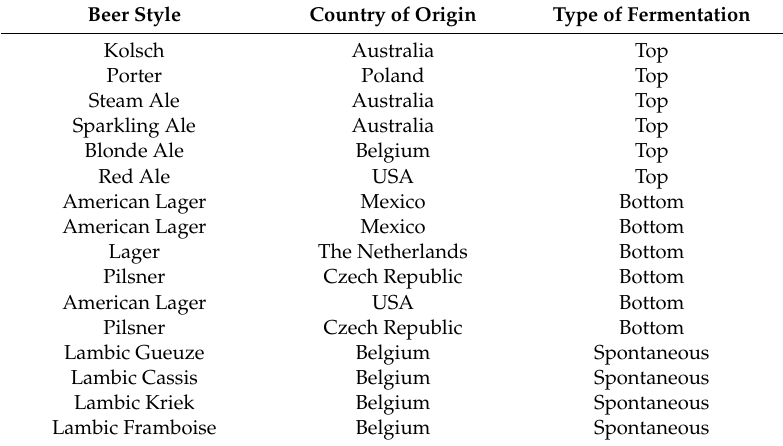
Table 1. List of samples used for the study, indicating their style, country of origin and type of